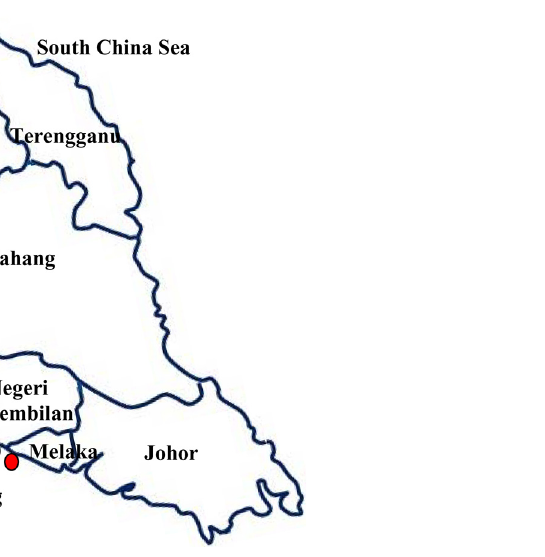
Fig 1. Location of marine fish sampling